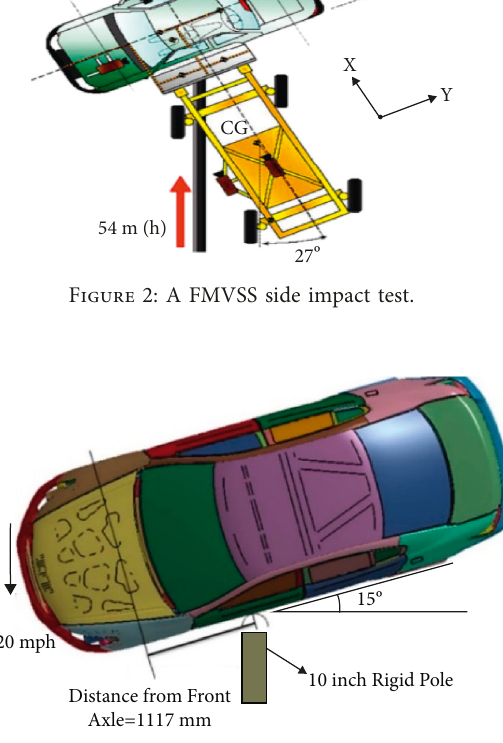
Figure 3: NACP side impact